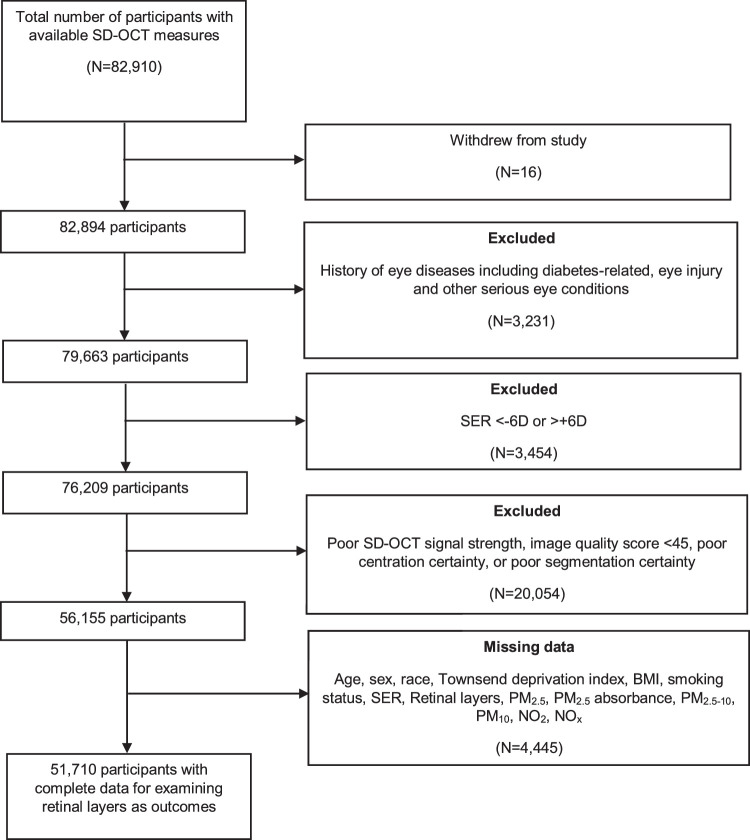
Flowchart of participants included in the study.